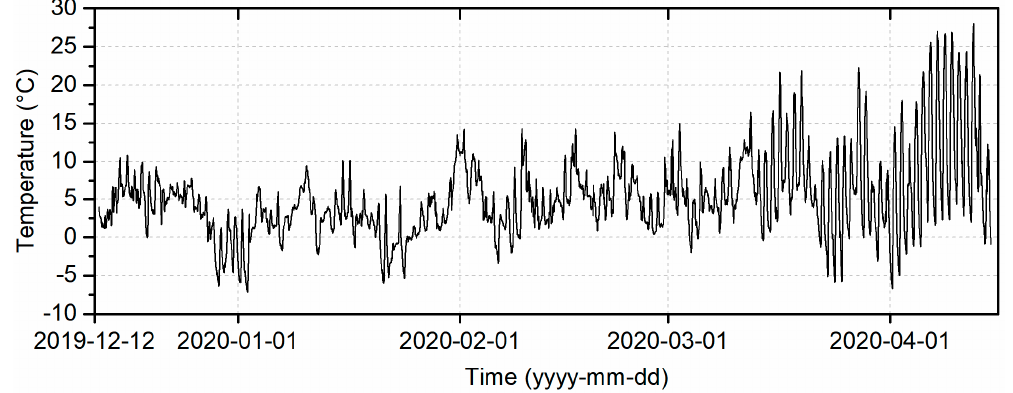
Figure 3. Measured ambient air temperature.